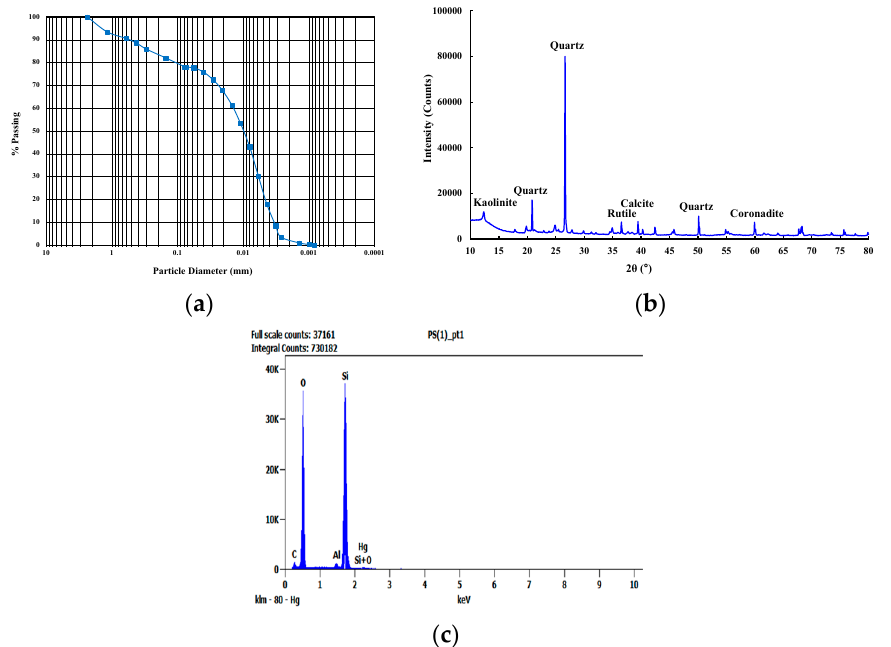
Figure 1. ( a ) Particle size distribution; ( b ) XRD patterns; ( c ) EDS patterns of soil.